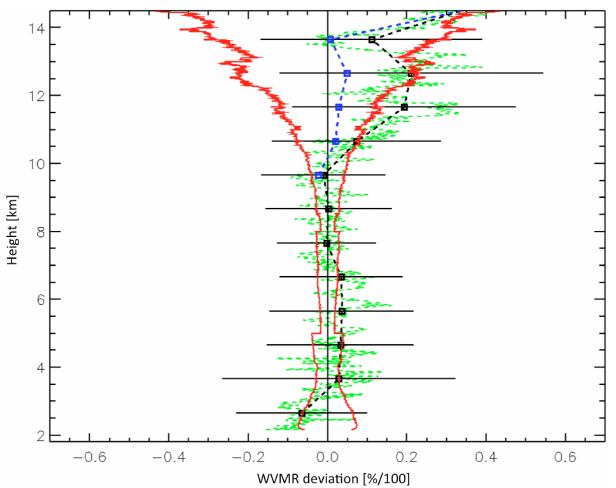
Figure 11. WVMR (lidar-RDS)/RDS relative difference (green dashed curve) between 12 RS92 flights and the 12 corresponding 1h integrated lidar profiles acquired during MALICCA. Black squares and horizontal bars depict the relative difference averaged on 1km thick layer and its related standard deviation, while the blue squares represent the WVMR relative deviation excluding the lidar-RS92 comparisons of 10 and 11 April. Red curves are the mean lidar sta- tistical